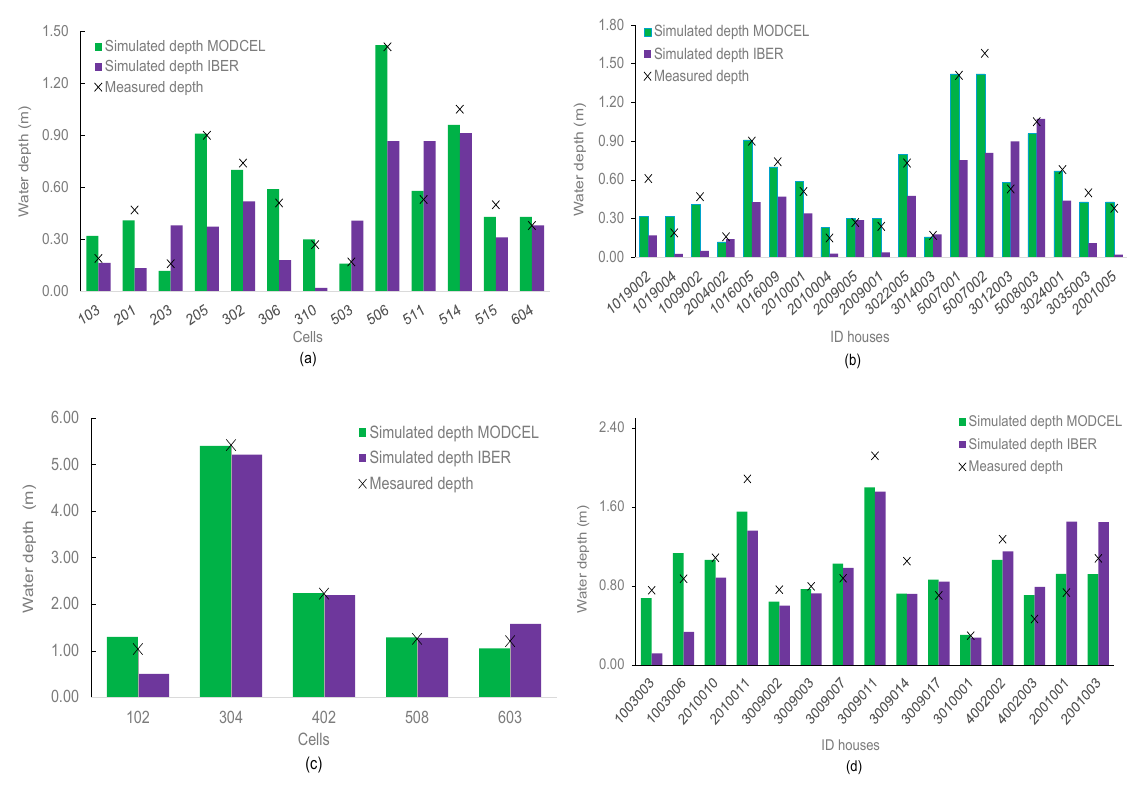
Figure 5. Comparison of water depth determined in the survey and simulated in calibration event: ( a ) transport type cell center; ( b ) in the houses located in the transport type cells; ( c ) tank type cells center; ( d ) houses located in the tank type cells. (Numbers in abscissa refer to cells codes).